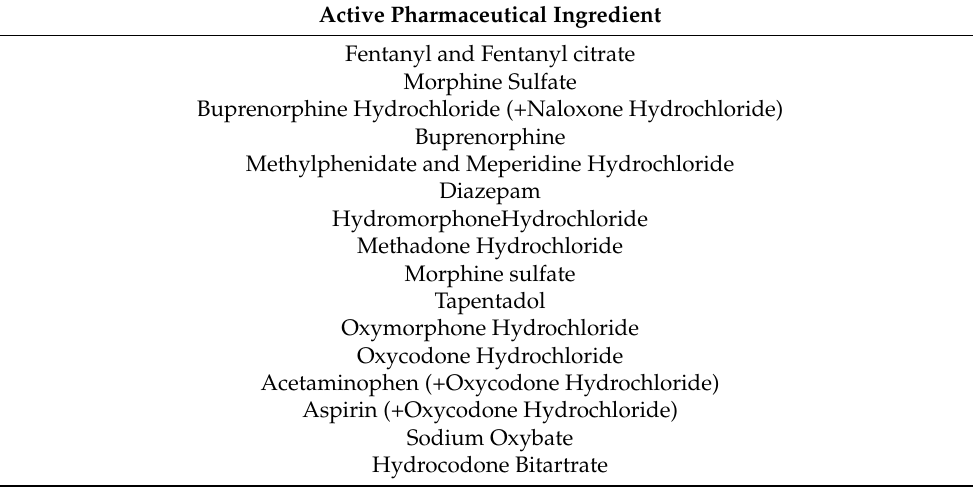
Table 3. Active pharmaceutical ingredients contained in medicines recommended being flushed into the toilet according to U. S.